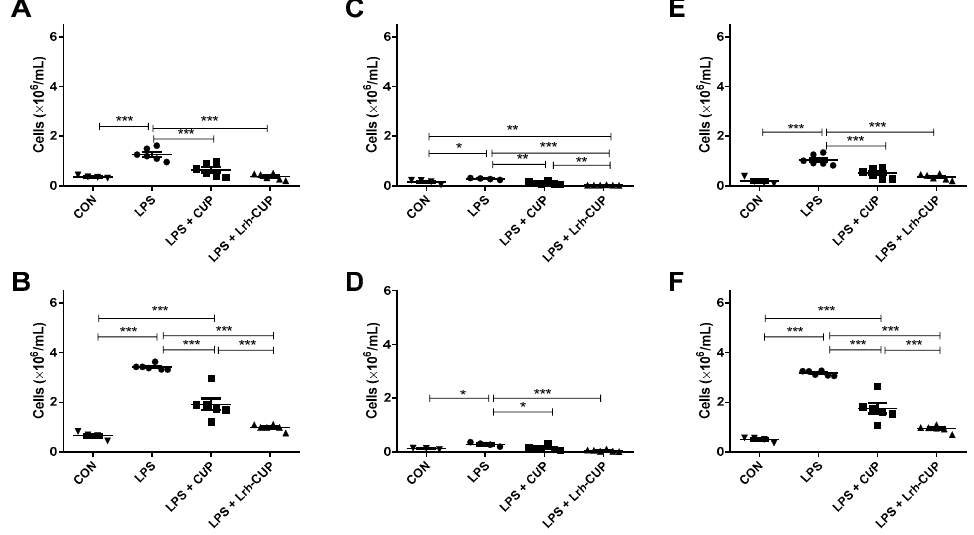
Figure 5. Effects of fermented and unfermented Theobroma grandiflorum juice in the migration of cells to the peritoneal cavity in mice submitted to LPS-mediated endotoxemia. ( A ) Total leukocytes in the peritoneal cavity after 6 h of LPS-mediated endotoxemia; ( B ) Polymorphonuclear leukocytes in the peritoneal cavity after 6 h of LPS-mediated endotoxemia; ( C ) Mononuclear cells in the peritoneal cavity after 6 h of LPS-mediated endotoxemia; ( D ) Total leukocytes in the peritoneal cavity after 120 h of LPS-mediated endotoxemia; ( E ) Polymorphonuclear leukocytes in the peritoneal cavity after 120 h of LPS-mediated endotoxemia; ( F ) Mononuclear cells in the peritoneal cavity after 120 h of LPS-mediated endotoxemia. * Significant differences with p < 0.05; ** Significant differences with p < 0.01; *** Significant differences with p < 0.0001. LPS: mice submitted to LPS-mediated endotoxemia; LPS + CUP: mice treated with unfermented T. grandiflorum juice and submitted to LPS-mediated endotoxemia; LPS + Lrh-CUP: mice treated with L. rhamnosus -fermented T. grandiflorum juice and submitted to LPS-mediated endotoxemia.